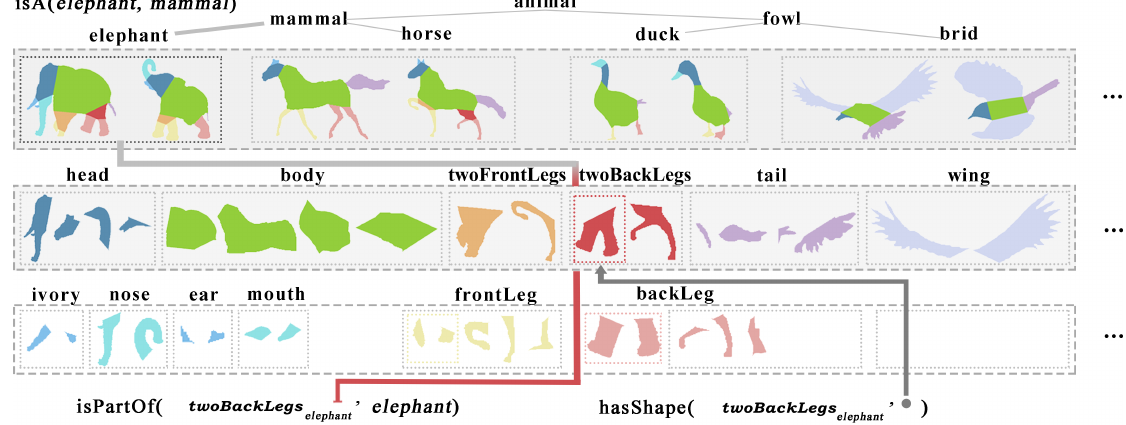
Figure 3: A snapshot of the knowledge in ShapeLearner’s hierarchy, zooming in on mammals and fowls. We show also a subset of the relational facts isA , isPartOf and hasShape